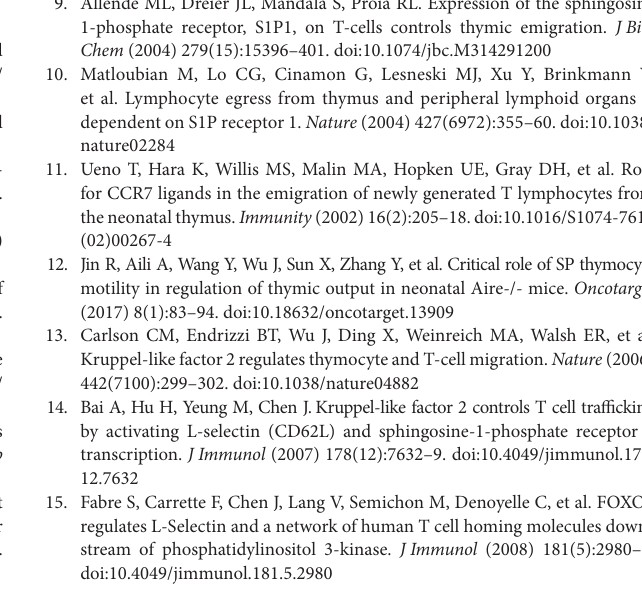
FigUre s3 | The expression of maturation-related markers on SP thymocyte from Ccr2 deficient mice. Thymocytes, splenocytes, and lymph node cells from 6-week-old Rag2p-EGFP Ccr2 knockout mice (red) and the wild-type littermates (black) were analyzed by flow cytometry. Representative histogram profiles of CD4 SP (a) and CD8 (B) thymocytes are presented out of two independent experiments. FigUre s4 | Akt and p-Akt levels in SP4 thymocytes. Purified SP4 thymocytes from 6-week-old C57BL/6 mice were stimulated with CCL2 or anti-CD3 Ab for 30 min. (a) Levels of phosphorylated Akt (p-Akt), total Akt were examined by Western blotting. The experiments were repeated three times with similar results. (B) The co-expression of CCR2 and S1P1 on SP4 thymocytes. Thymocytes collected from 6-week-old Rag2p-EGFP mice were stained with antibodies to CD4, CD8, CD69, Qa-2, CCR2, and S1P1. GFP + CD4 + CD8 − CD69 − Qa-2 + SP4 or GFP + CD4 − CD8 + Qa-2 + thymocytes were gated for CCR2 and S1P1 analysis. The experiments were repeated three times with similar results. MOvie s1 | Migration of CCR2 + / + (red) and CCR2 − / − (green) CD4 SP4 cells within the medulla of a live thymic slice. Time-lapse images were acquired every 20 s during 15 min detection time by two-photon microscopy. This movie correlates with Figures 4B,c . MOvie s2 | Migration of CCR2 + / + (red) and CCR2 − / − (green) CD4 SP4 cells on fibronectin coated glass plates in the medium without any chemokine. Frames were acquired at 20 s intervals during 20 min detection time by confocal microscope. This movie correlates with Figures 4D,e . MOvie s3 | Migration of CCR2 + / + (red) and CCR2 − / − (green) CD4 SP4 cells on fibronectin coated glass plates in the medium containing 100 ng/ml CCL2. Frames were acquired at 20 s intervals during 20 min detection time by confocal microscope. This movie correlates with Figures 4D,e . MOvie s4 | Migration of CCR2 + / + (red) and CCR2 − / − (green) CD4 SP4 cells toward S1P on fibronectin coated glass plates. Frames were acquired at 20 s intervals during 20 min detection time by confocal microscope. This movie correlates with Figures 4D,e . MOvie s5 | Migration of CCR2 + / + (red) and CCR2 − / − (green) CD4 SP4 cells toward S1P in the presence of homogeneously distributed CCL2 on fibronectin coated glass plates. Frames were acquired at 20 s intervals during 20 min detection time by confocal microscope. This movie correlates with Figures